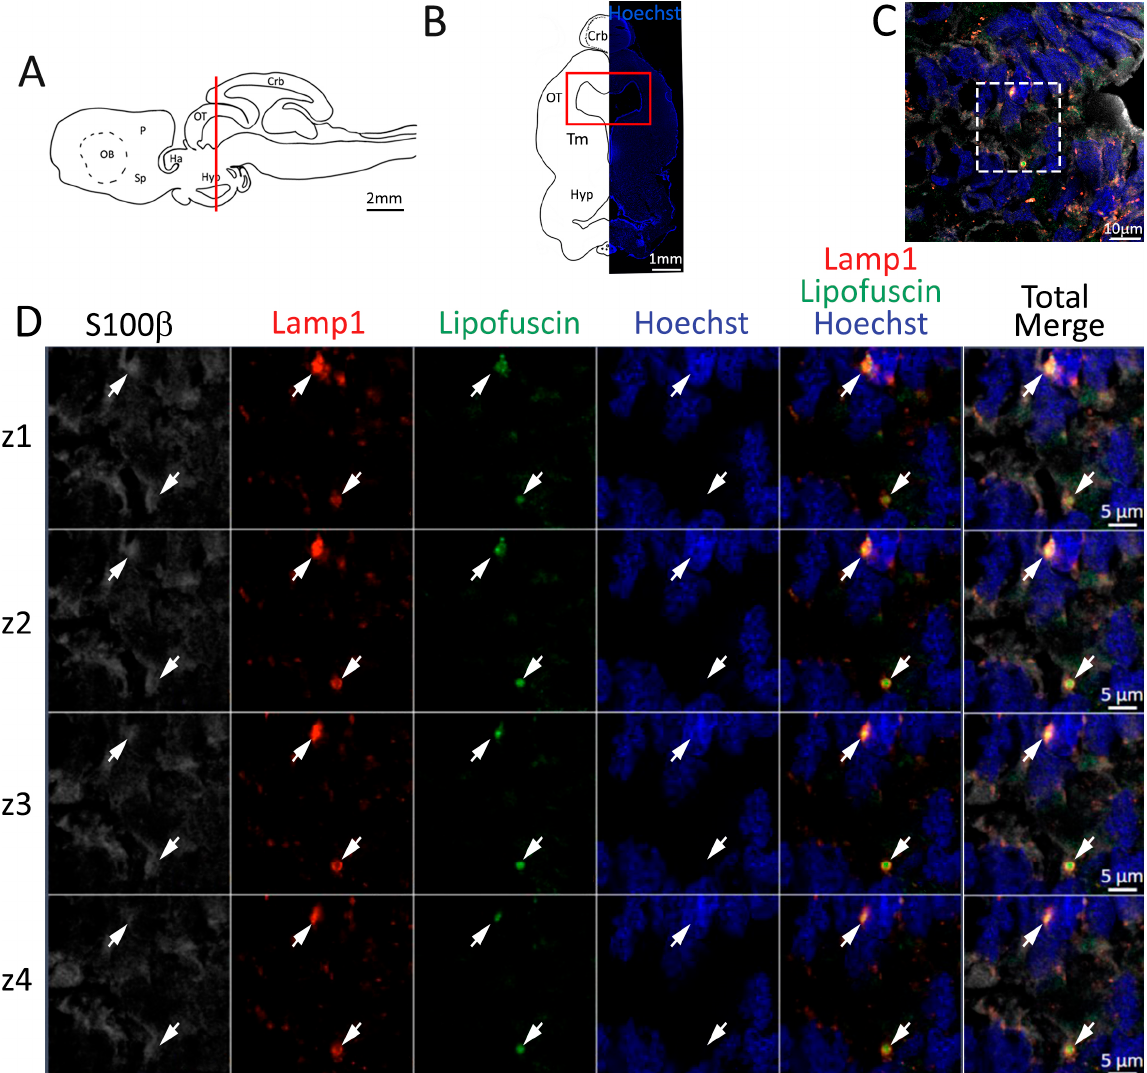
Figure 12. Presence of lipofuscin aggregates inside lysosomes in the mesencephalon of S. canicula . ( A ) Sagittal representation of S. canicula brain. The red line indicates the rostro-caudal localization of the section represented in the panel. ( B ) Coronal map of the area imaged. On the right, a real coronal section is stained with Hoechst 33342 to show nuclei distribution; on the left, a cartoon is drawn to indicate anatomical references. Red rectangle identifies the general area from which images are taken. ( C ) Area of the neurogenic niche where magnifications are taken from. ( D ) Lysosomes (Lamp1, red) containing lipofuscin (green) localized in radial glial cells (S100 β + , white) and are localized around the nucleus (Hoechst, blue). In the panel, four consecutive z planes are represented ( z1 – z4 ) to render the three-dimensionality of the inclusion. Each plane is acquired at 1 µ m step in the z-axis from the previous. Last column represents the overlay of all four channels. White arrows indicate the localization of lysosomes containing lipofuscin. Abbreviations: Crb: cerebellum, OT: optic tectum, Tm: tegmentum, Hyp: